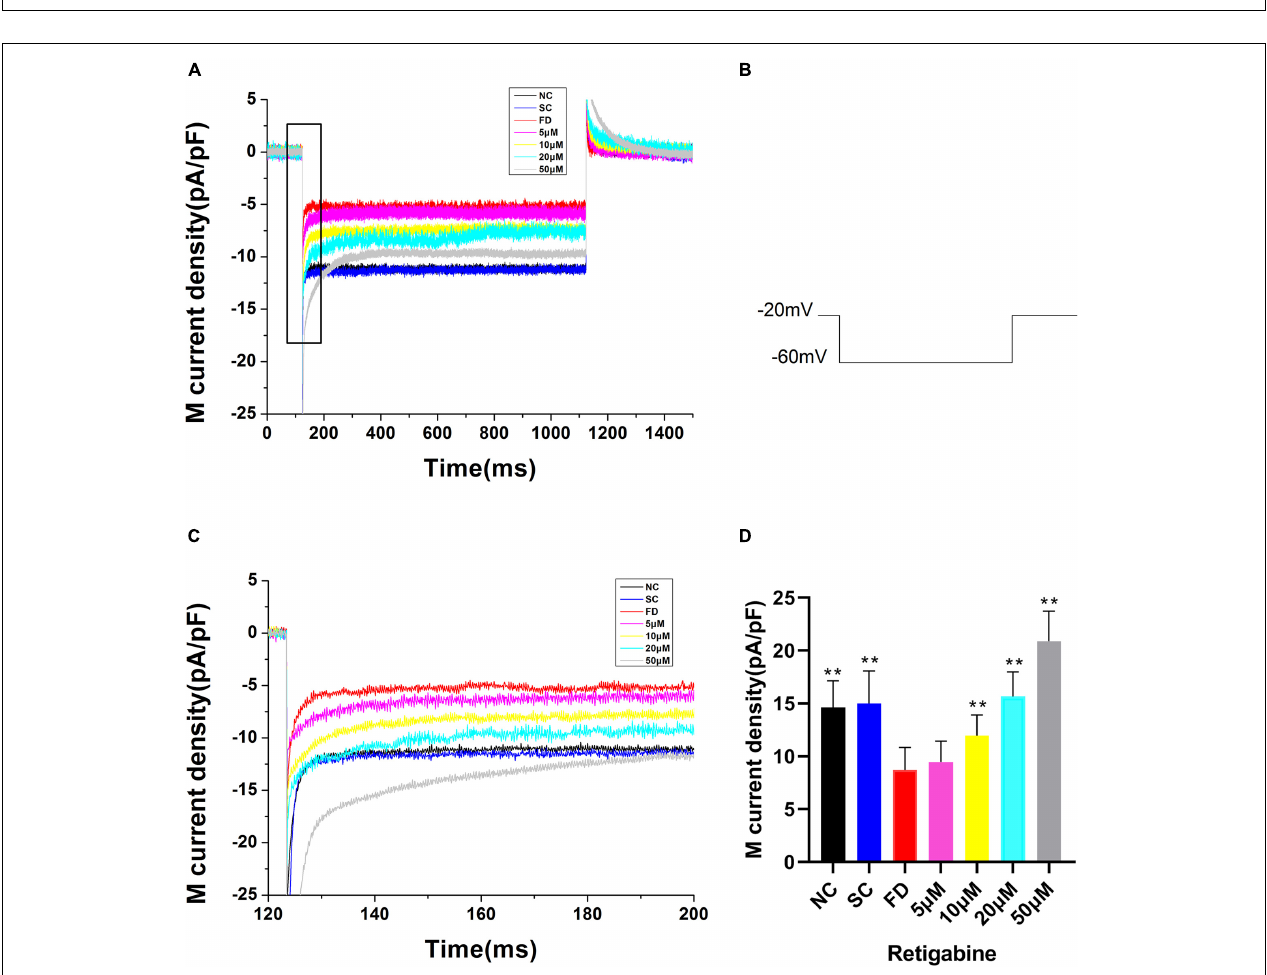
FIGURE 7 | M-currents treated with Retigabine in the FD group. (A) I K ( M ) Density of RPE cells treated with different concentrations of Retigabine. (a) Black, before administration; (b) Red, 5 µ M; (c) Blue, 10 µ M; (d) Purple, 20 µ M; (e) Gray, 50 µ M. (B) Protocol for recording M-current. (C) The expanded recordings from the dashed box in (A) , and indicated the effect of Retigabine on the I K ( M ) density. (D) Statistical graph of the I K ( M ) density of each group. When the concentration increased to 10, 20, and 50 µ M, the differences were statistically significant (** P < 0.01).